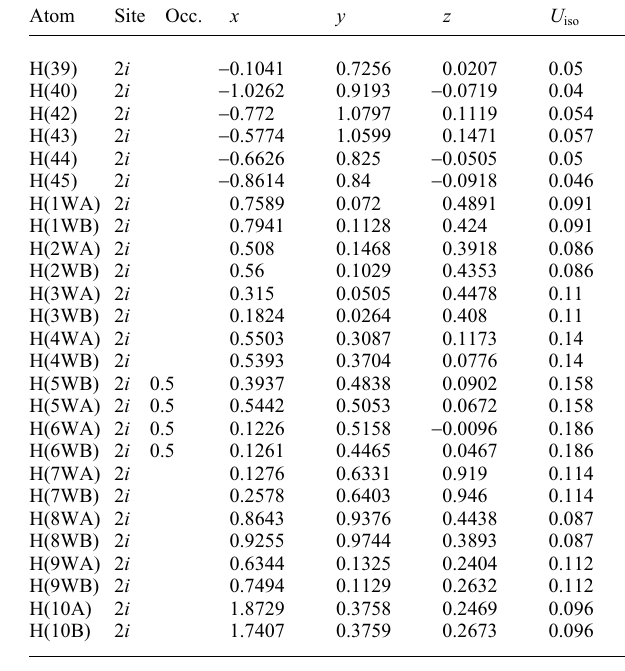
Table 2. Atomic coordinates and displacement parameters (in Å 2 ) . Atom Site